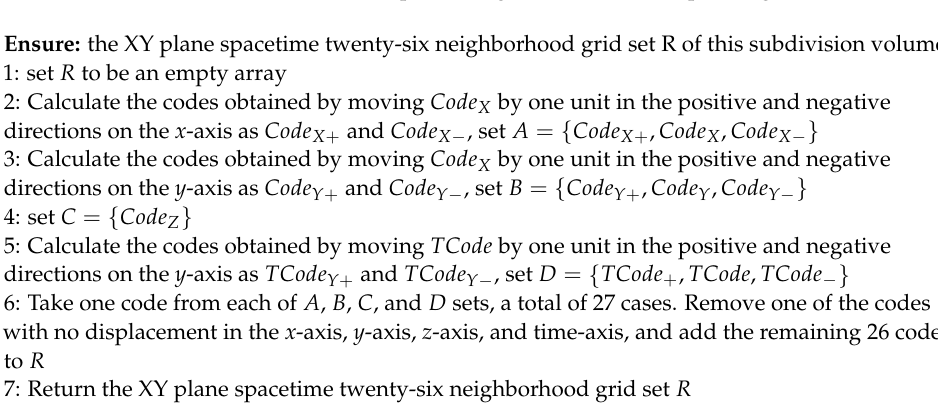
Algorithm 5: Algorithm of XY plane spacetime eight neighborhoods.